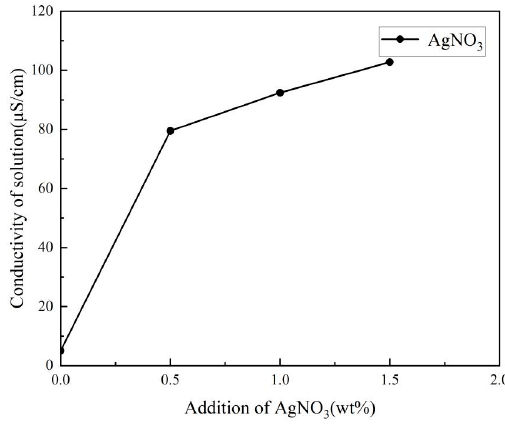
Figure 5. The conductivity of electrospinning solution with different addition of AgNO 3.